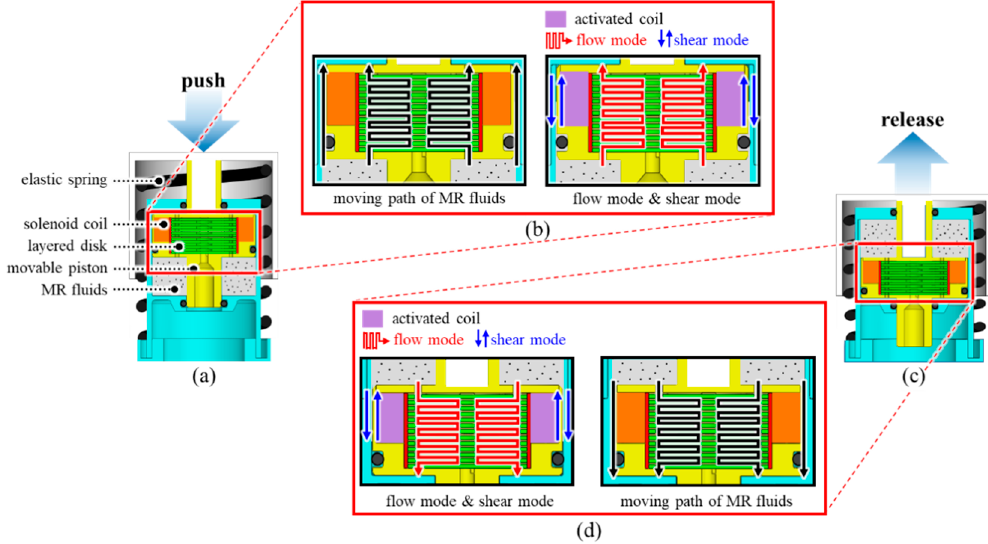
Figure 4. Operating principle and mechanism of the proposed MR actuator: ( a ) At the resting state (not pressed); ( b ) Operating principle when push is applied; ( c ) At the pressed state; ( d ) Operating principle when push is released.